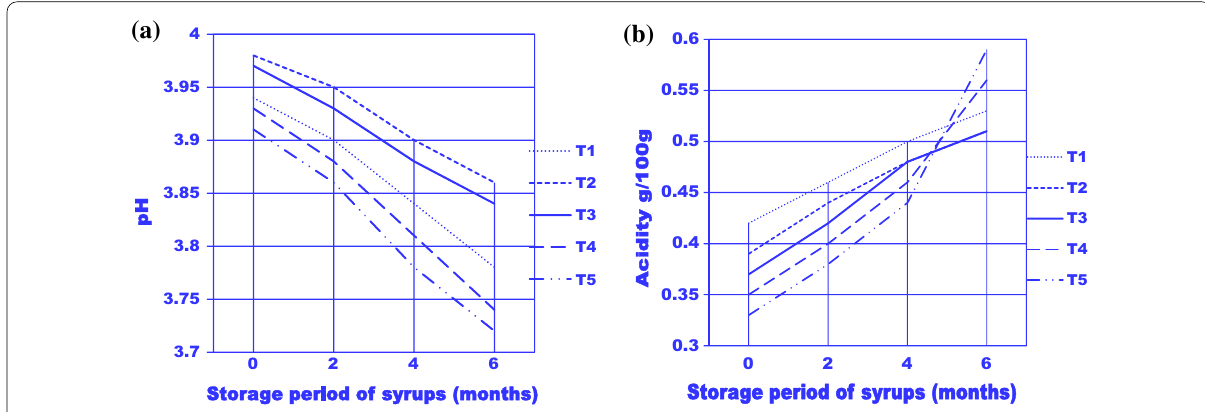
Fig. 1 Change in pH and acidity in different syrups during the storage period